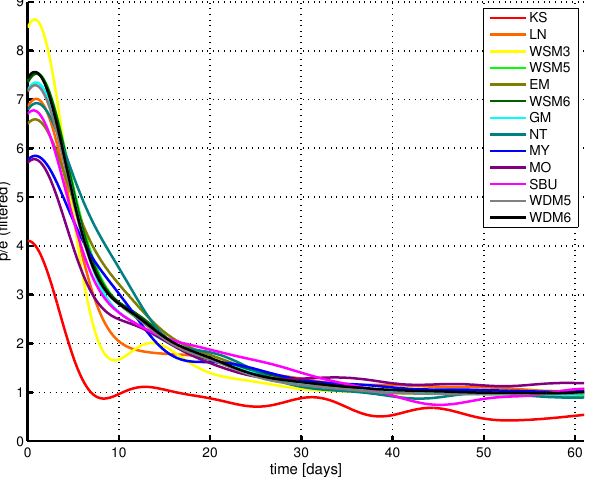
Fig. 8. The ratio between precipitation rate and evaporation rate for the 13 microphysical schemes. The series have been filtered with a 10day lowpass filter. For p/e → 1 the closed system reaches its